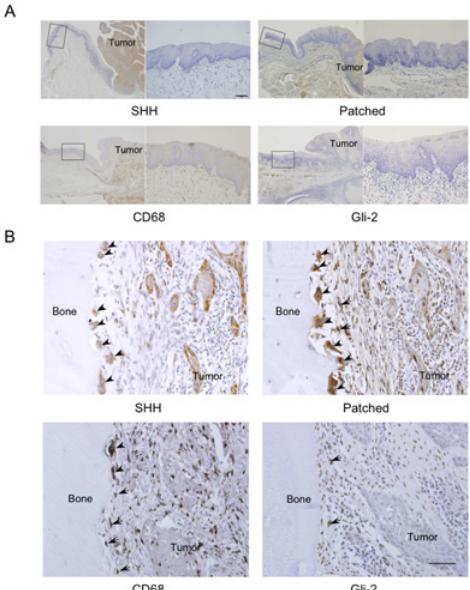
Fig 1. Immunohistochemical staining for Sonic hedgehog (SHH), Patched, CD68 and Gli-2 in normal epithelium and osteolytic mandibular squamous cell carcinoma. (A) SHH, Patched, CD68 and Gli-2 expression in the normal epithelium at the edges of area were the mandible was resected. Each right photo is a magnification of the rectangle delimited area of normal epithelium in the corresponding left photo. Scale bar, 50 μ m. (B) SHH, Patched, CD68 and Gli-2 expression in a resected mandible. Scale bar, 50 μ m. Arrow: osteoclast. Arrowhead: osteoclasts progenitor cell.